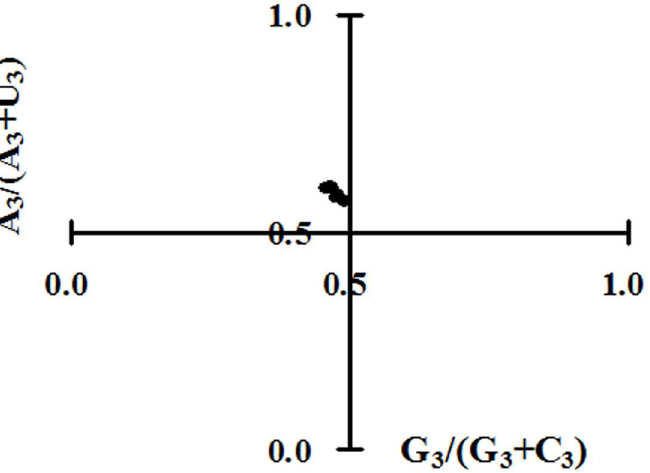
Fig 6. Parity rule 2 (PR2) plot [A 3 /(A 3 +U 3 ) against G 3 /(G 3 +C 3 )]. PR2 bias plot was calculatedfor each polyprotein-codingregionof